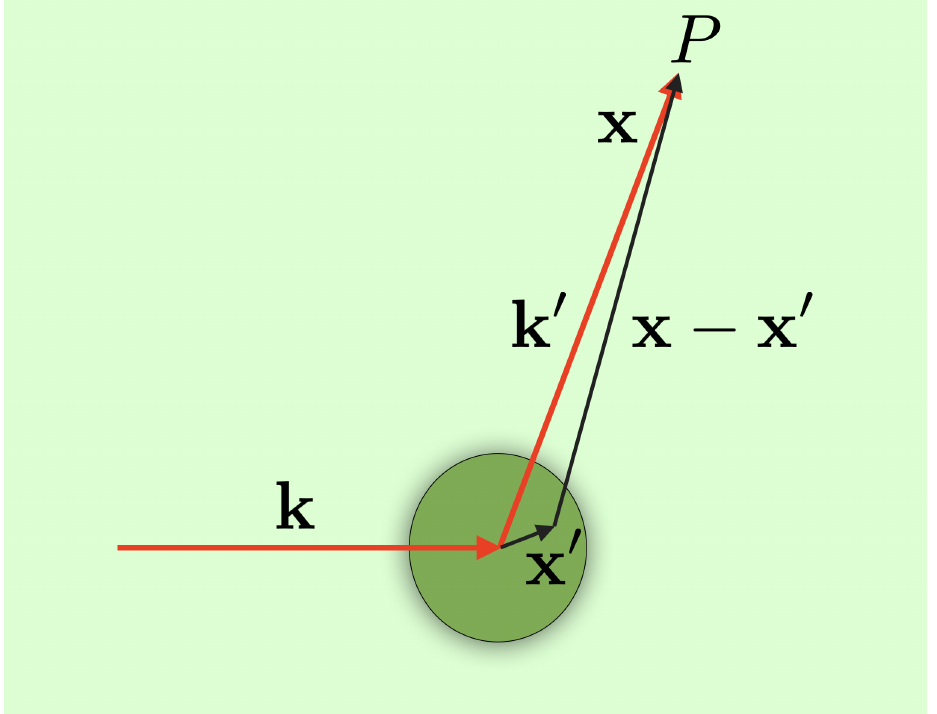
Figure 2. Pictorial description of the scattering event on a plane perpendicular to the cylindrical defect